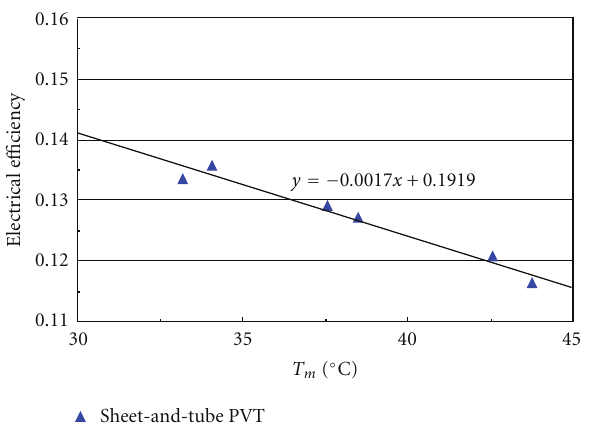
Figure 8: Electrical e ffi ciency of the sheet-and-tube PVT collector as a function of the mean fluid temperature.